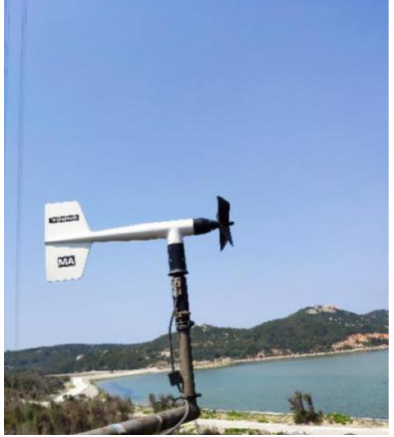
Figure 3. Vane type